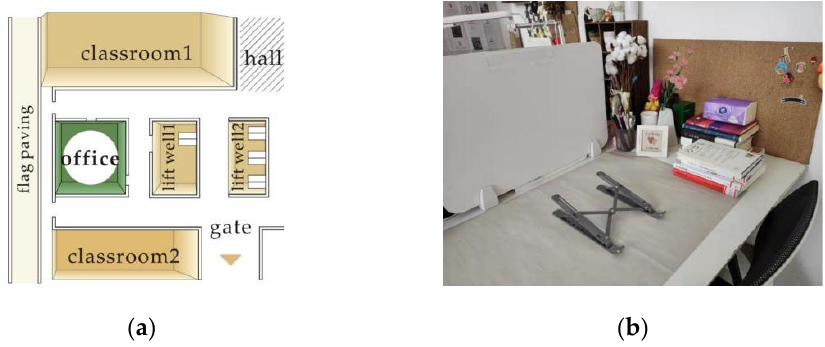
Figure 2. ( a ) Location of open ‐ plan studio; ( b ) test environment in open ‐ plan